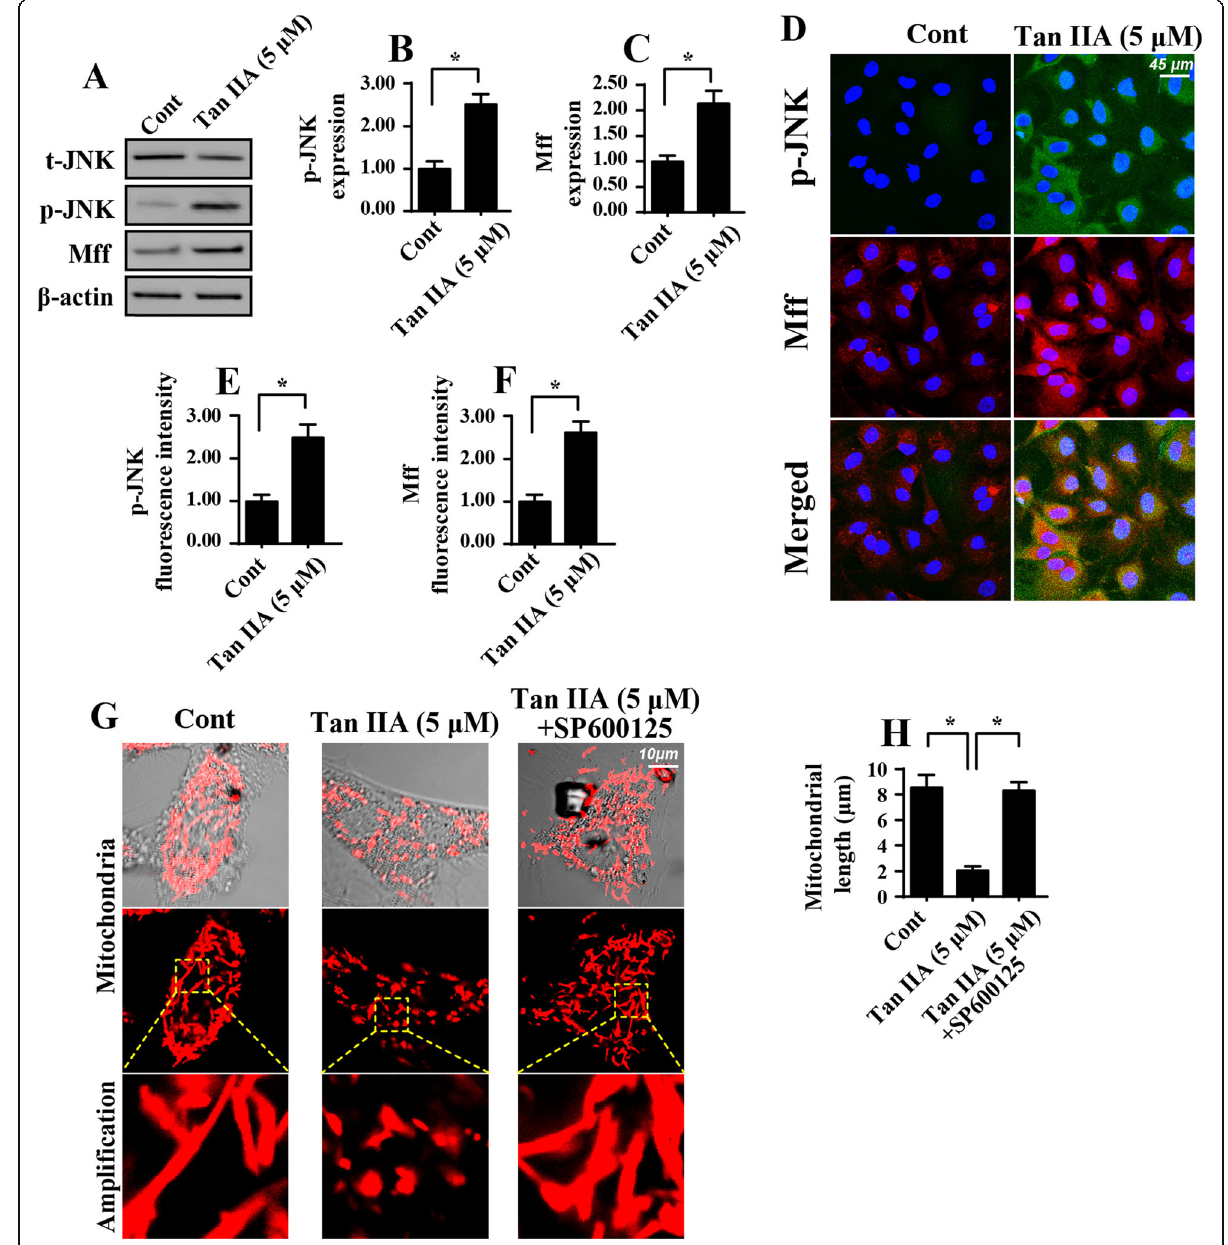
Fig. 7 Tan IIA activates mitochondrial fission via the JNK-Mff pathways. a-c Western blotting was conducted to verify the alteration of JNK phosphorylation and Mff expression. d-f Immunofluorescence assays for JNK phosphorylation and Mff expression. Tan IIA treatment significantly increased the expression of p-JNK and Mff. g-h Mitochondrial fission was observed via immunofluorescence using the mitochondrial-specific antibody Tom-20. The average length of the mitochondria was recorded. SP600125, an inhibitor of JNK, was added to the Tan IIA-treated cells to prevent JNK activation. * p <